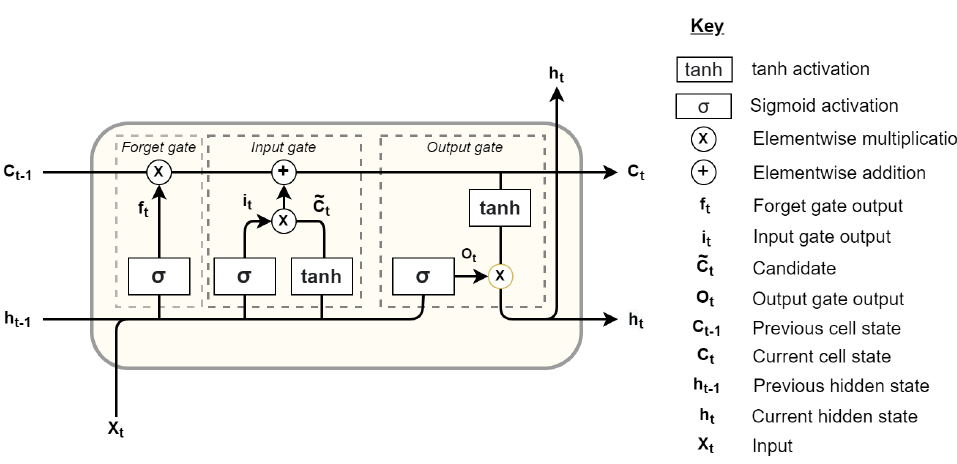
Figure 1. Visualisation of the LSTM cell